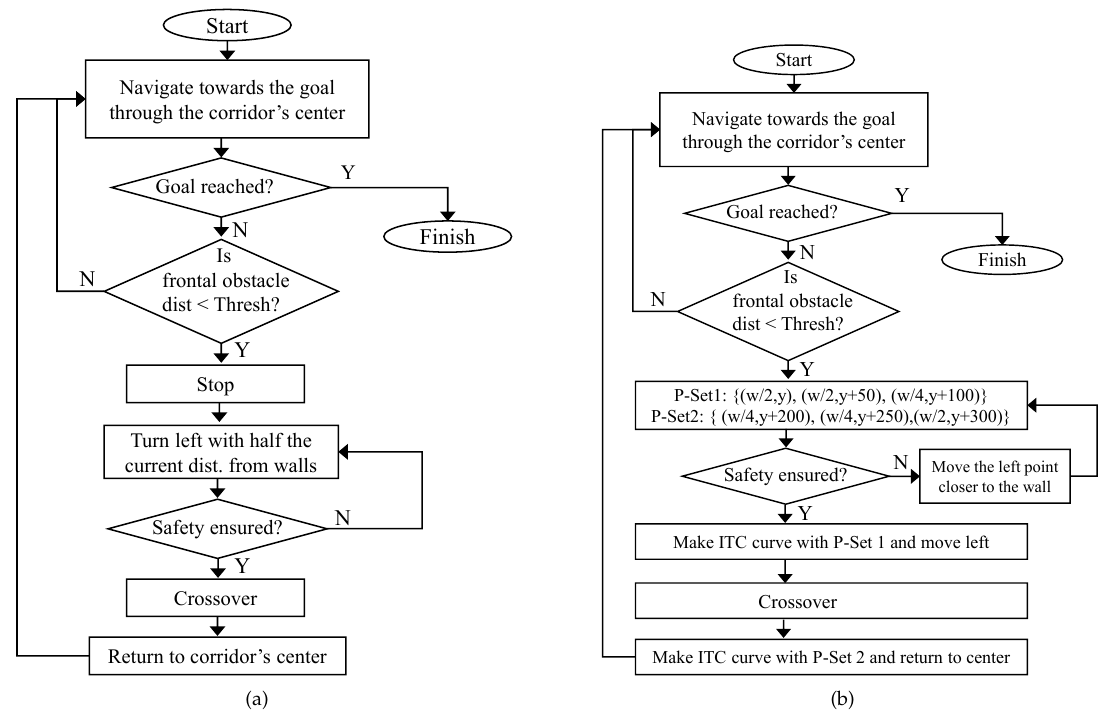
Figure 18. Flowchart of non-smoothed and ITC based smooth navigation and collision avoidance. ( a ) non-smoothed case; ( b ) ITC based smoothed